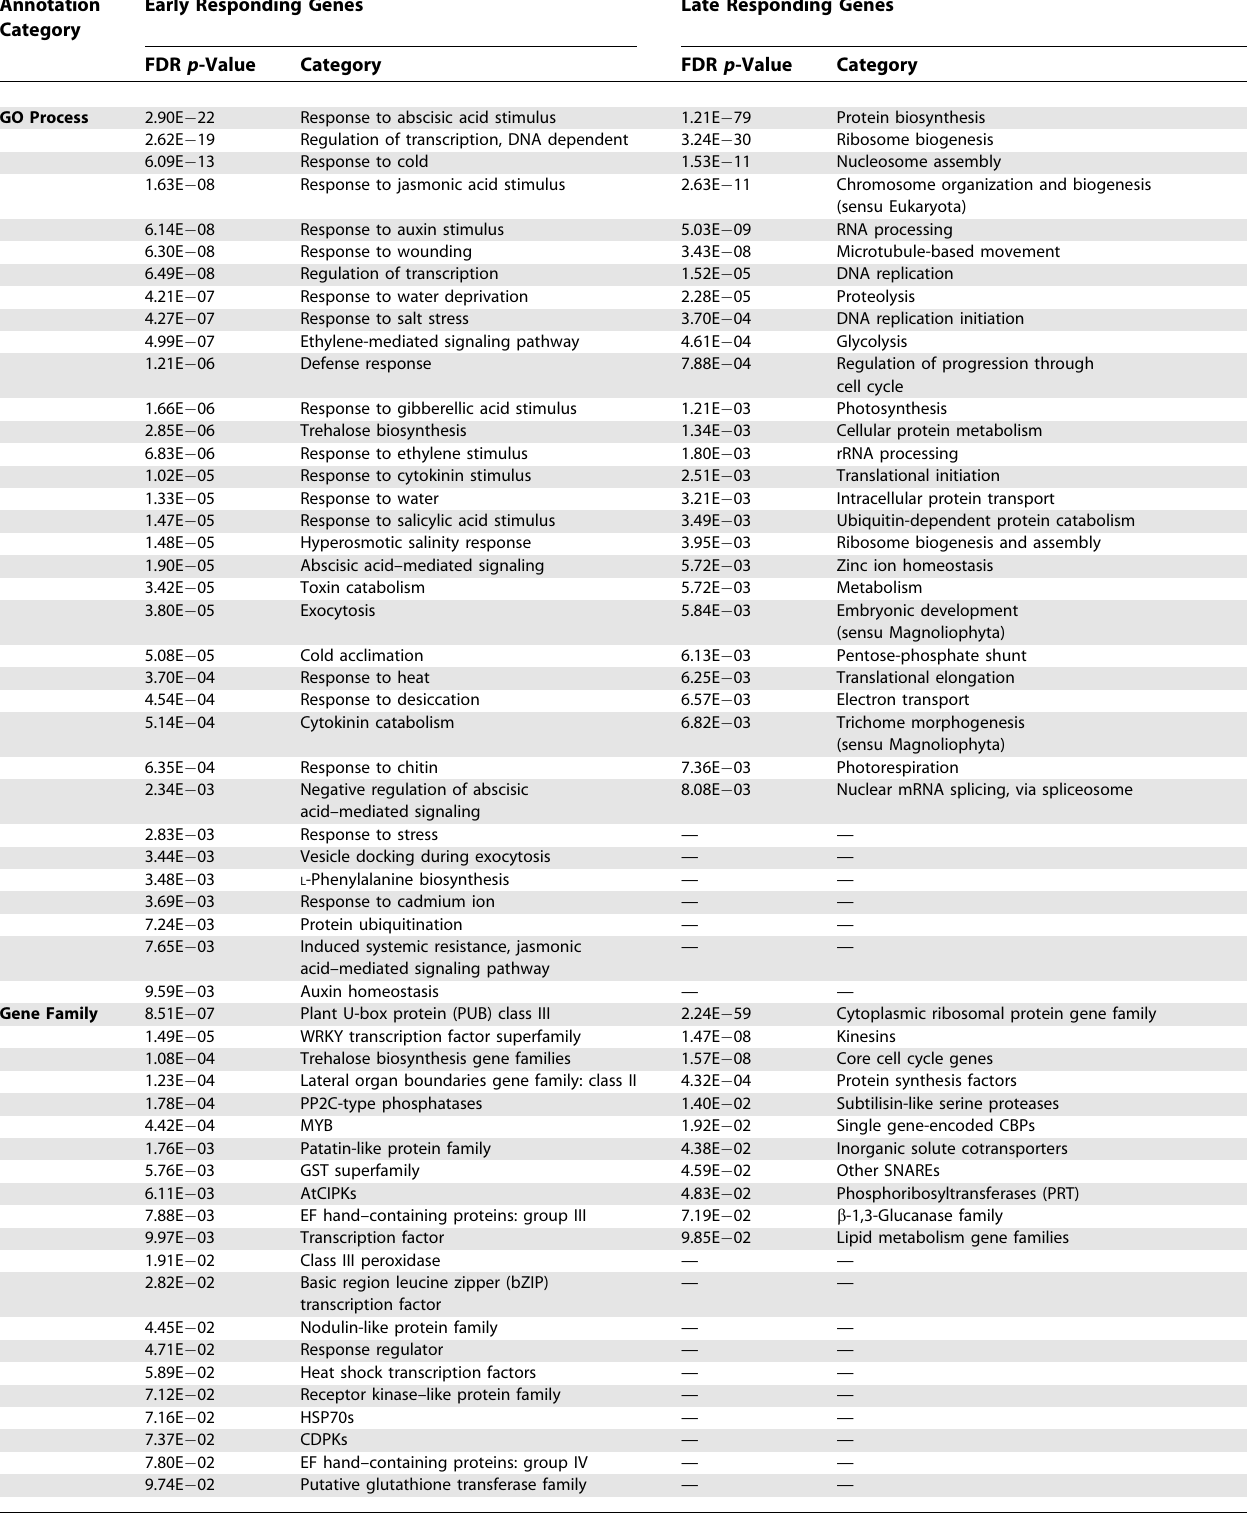
Table 4. GO Process and Gene Family Annotations Associated with Genes Differentially Expressed Early (3 h or Earlier [Left]) and Late (After 3 h [Right]) after Abiotic Stress Stimulus in Nine different Abiotic Stress Time Series Experiments and in Root and Shoot Tissue, Respectively (Table